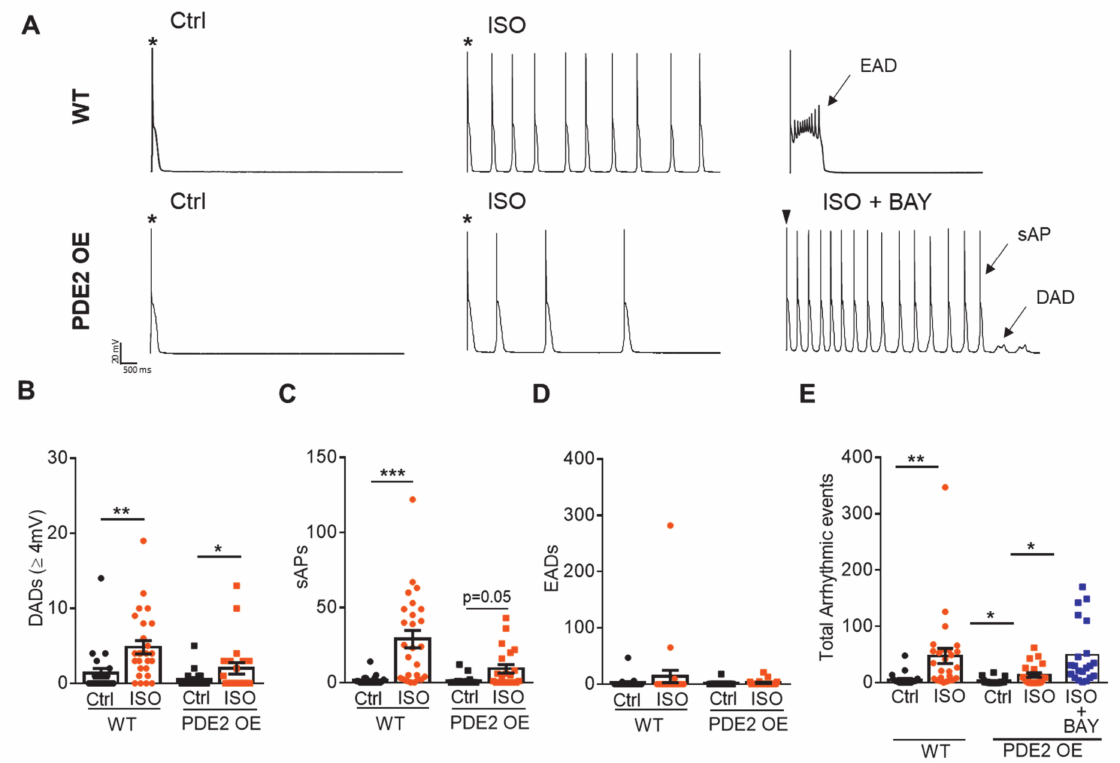
Figure 1. PDE2 OE display diminished cellular arrhythmogenic events. ( A ) Representative traces recorded in whole-cell patch clamp mode from WT (upper) and PDE2 OE (lower) ventricular cardiomyocytes upon stimulation at 0.125 Hz following stimulation at 4 Hz. Stars represent the stimulated action potentials; the following signals are spontaneous. Measurements were performed under basal conditions (Ctrl, black symbols) and upon β -adrenergic stimulation with isoprenaline (ISO, 100 nM, 10 min, orange symbols) and simultaneous PDE2 inhibition with BAY60-7550 (BAY, 100 nM). Quantification of ( B ) delayed afterdepolarizations (DAD, ≥ 4 mV), ( C ) spontaneous action potentials (sAP), ( D ) early afterdepolarizations (EAD), and ( E ) total number of arrhythmic events per cell in WT (circles) and PDE2 OE (squares). * p < 0.05, ** p < 0.01, *** p < 0.001 (N = 8 animals/genotype, 20 ≤ n ≤ 26